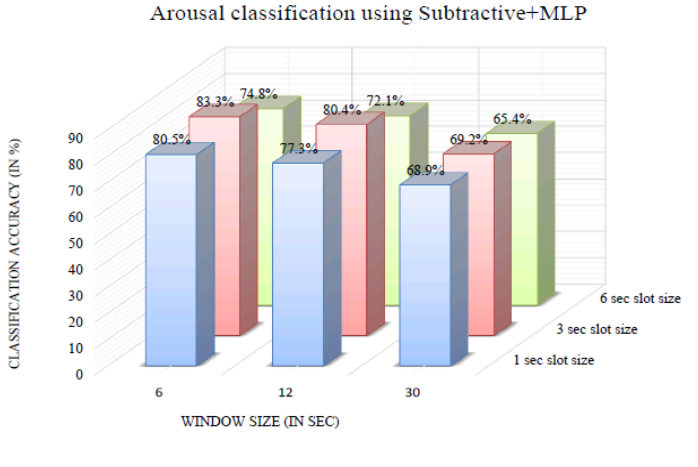
Figure 7. Arousal classification accuracy of the subtractive+MLP method for various window